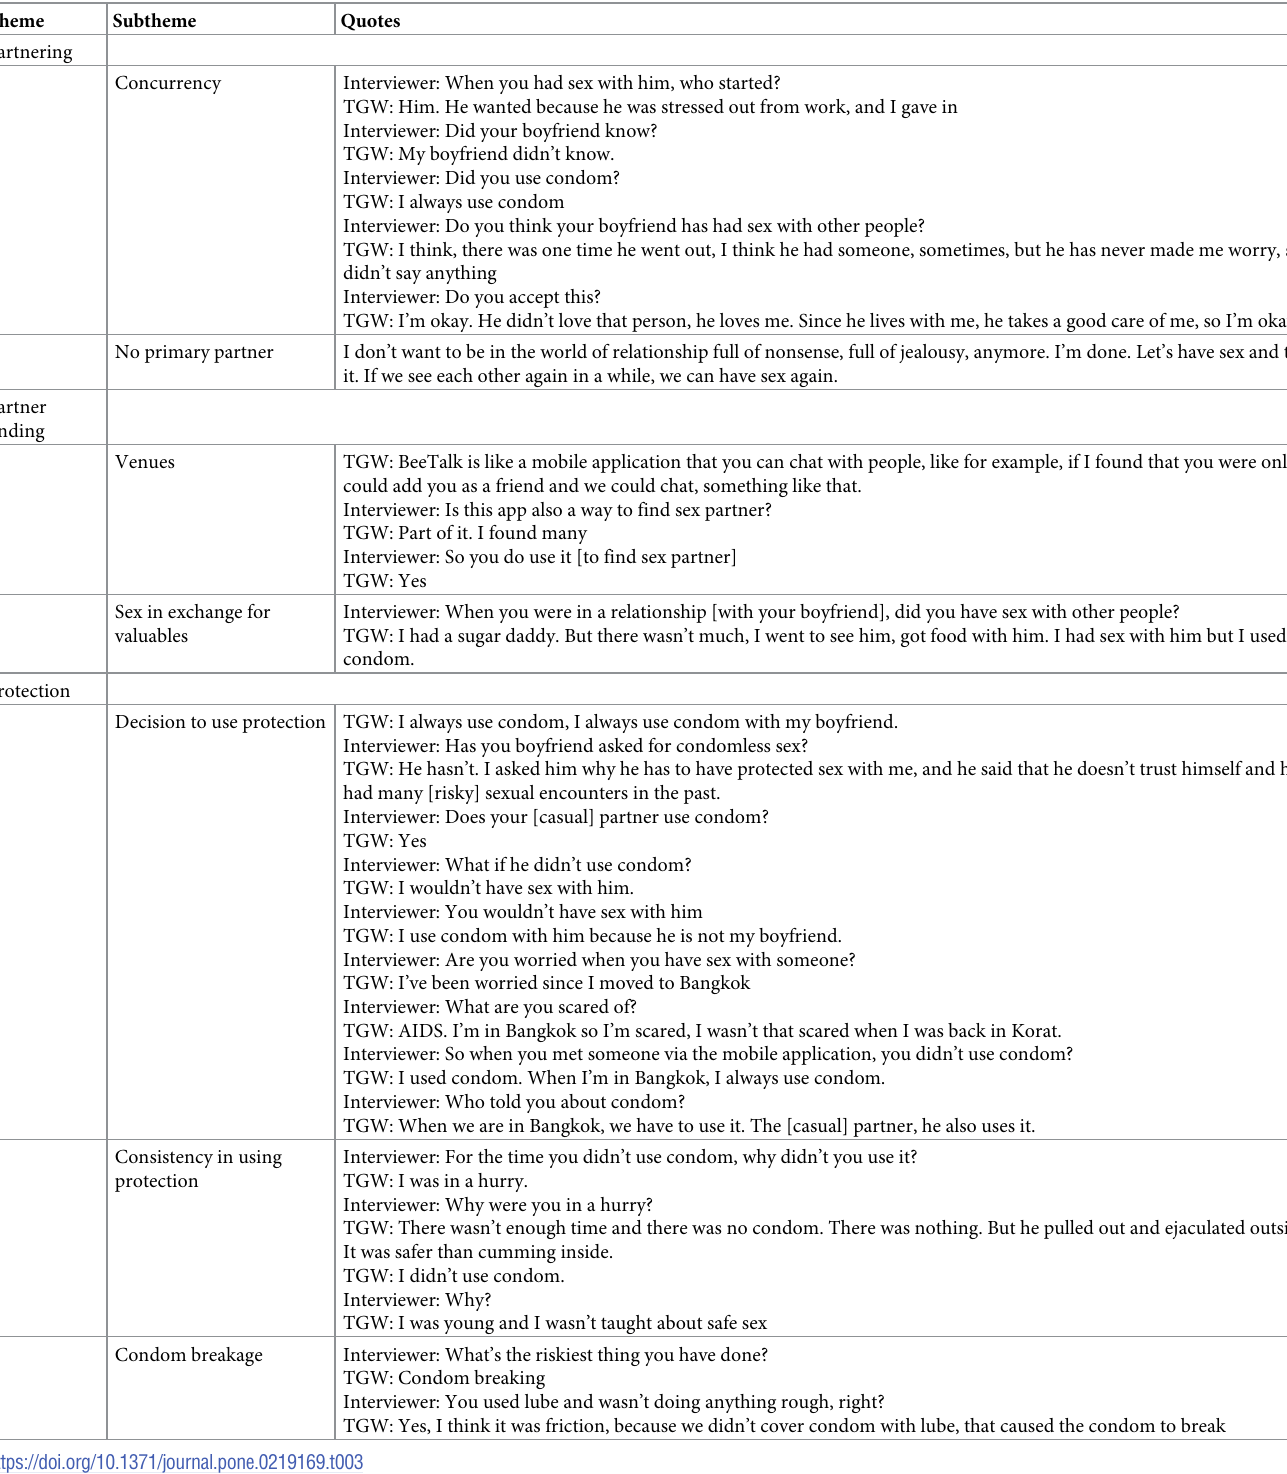
Table 3. Themes for TGW